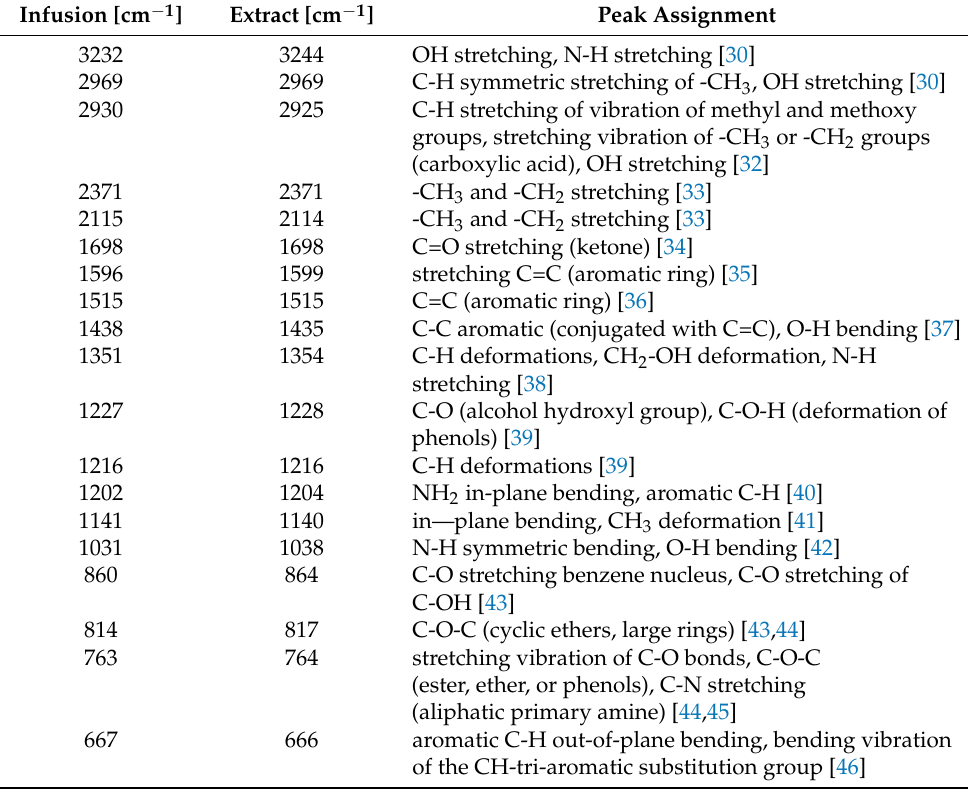
Table 2. IR band assignment of the C. incanus leaves extract and